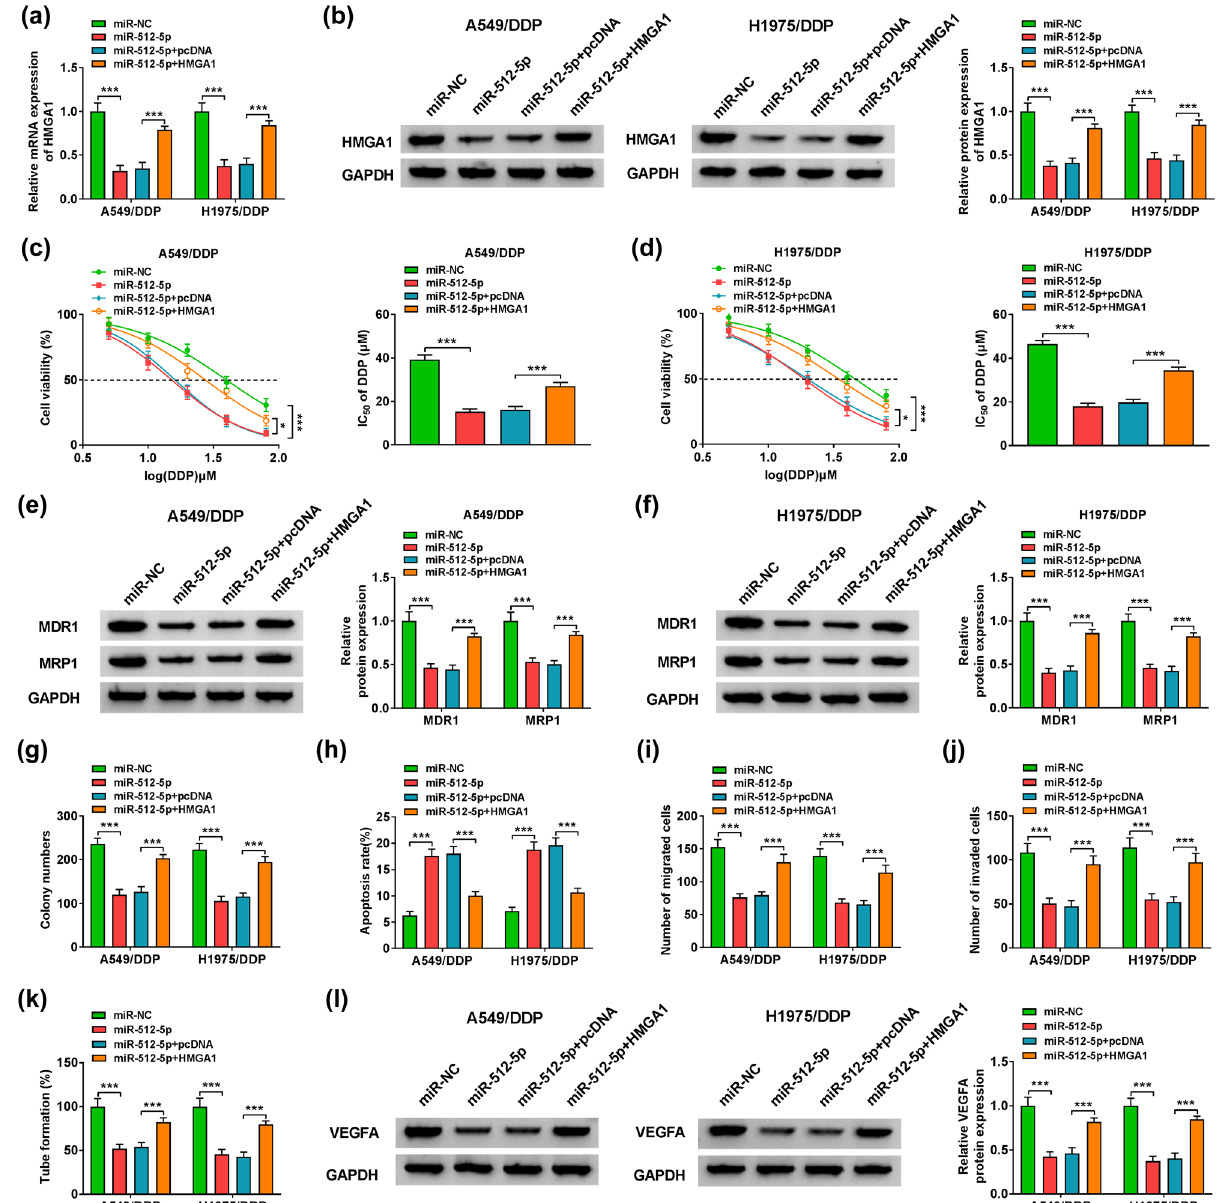
Figure 6: Overexpression HMGA1 could reverse the in fl uence of miR - 512 - 5p in lung adenocarcinoma DDP - resistant cells. A549/DDP and H1975/DDP cells were transfected with miR - NC, miR - 512 - 5p, miR - 512 - 5p + pcDNA, or miR - 512 - 5p + HMGA1. ( a ) The mRNA level of HMGA1 was analyzed by RT - qPCR. ( b ) The protein level of HMGA1 was detected by western blot. ( c and d ) Cell viability and IC 50 value were measured by MTT assay. ( e and f ) The protein levels of MDR1 and MRP1 were analyzed by western blot. ( g ) The number of colonies were analyzed by colony formation assay. ( h ) Flow cytometry was used to detect cell apoptosis. ( i and j ) Cell migration and invasion were analyzed by transwell assay. ( k ) Tube formation was analyzed by tube formation assay. ( l ) Western blot was performed to analyze the protein level of VEGFA. *P < 0.05, ** P < 0.01, ***P <